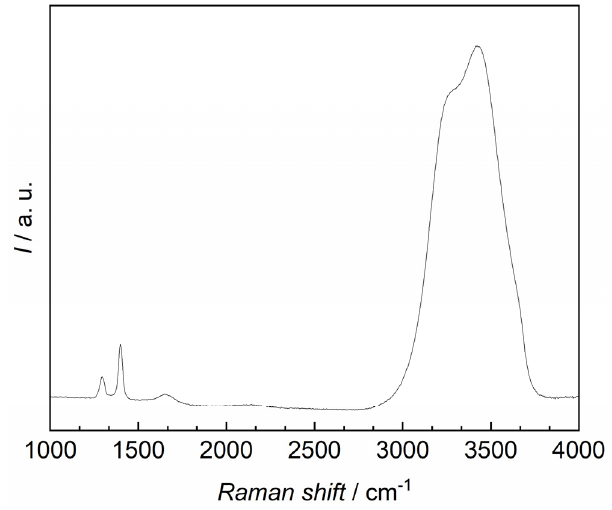
Figure A1. Raman spectrum of dissolved carbon dioxide in water at T = 288.15 K and p = 4 MPa. Different bands of carbon dioxide (1250–1450) cm − 1 and water ~1649 cm − 1 , (2750–3750) cm − 1 are displayed at the respective Raman shift.